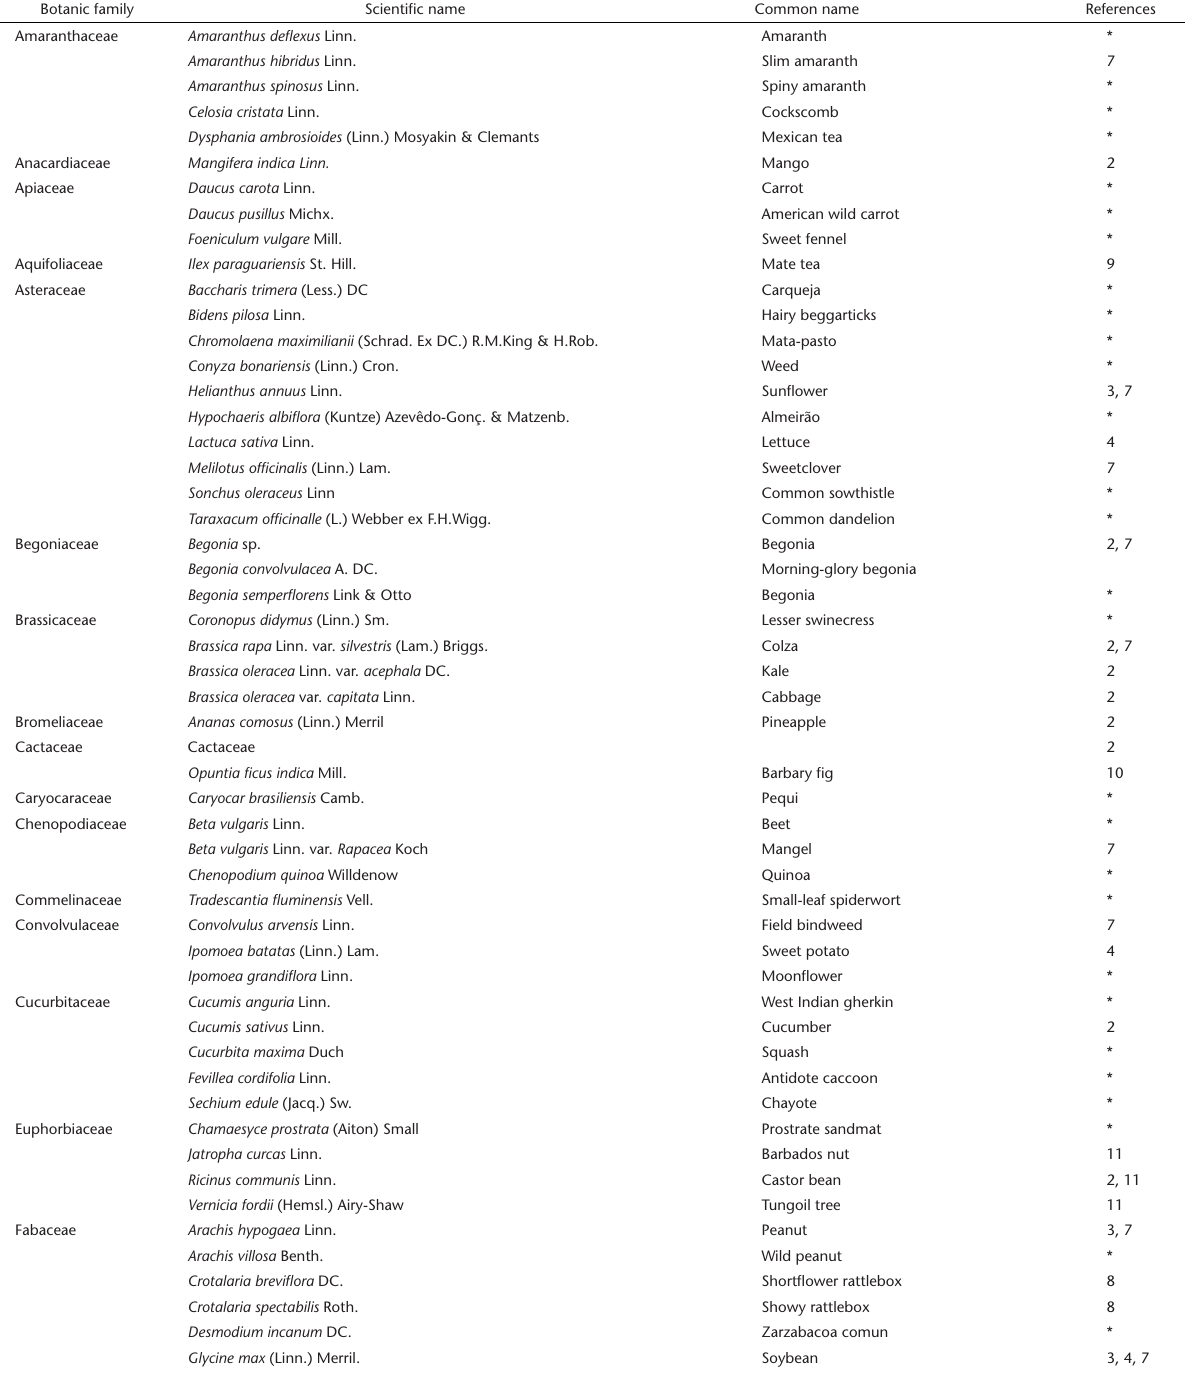
Amaranth * Slim amaranth 7 Spiny amaranth * Cockscomb * Mexican tea * Mango 2 Carrot * American wild carrot * Sweet fennel * Mate tea 9 Carqueja * Hairy beggarticks * Mata-pasto * Weed * Sunflower 3, 7 Almeirão * Lettuce 4 Sweetclover 7 Common sowthistle * Common dandelion * Begonia 2, 7 Morning-glory begonia Begonia * Lesser swinecress * Colza 2, 7 Kale 2 Cabbage 2 Pineapple 2 2 Barbary fig 10 Pequi * Quinoa * Squash * Wild peanut * Shortflower rattlebox 8